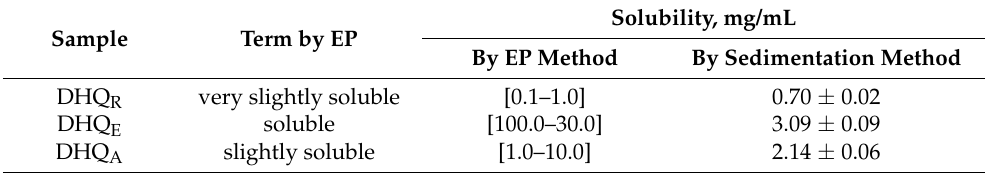
Table 2. Solubility of DHQ substances.